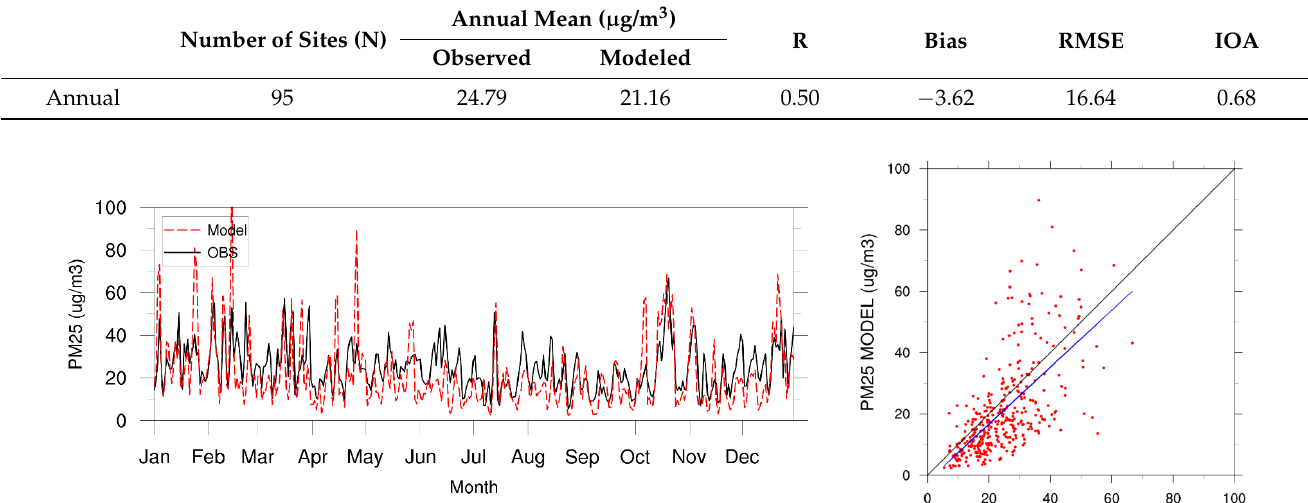
Table 2. Statistics for PM 2.5 at the South Korea air quality monitoring stations.